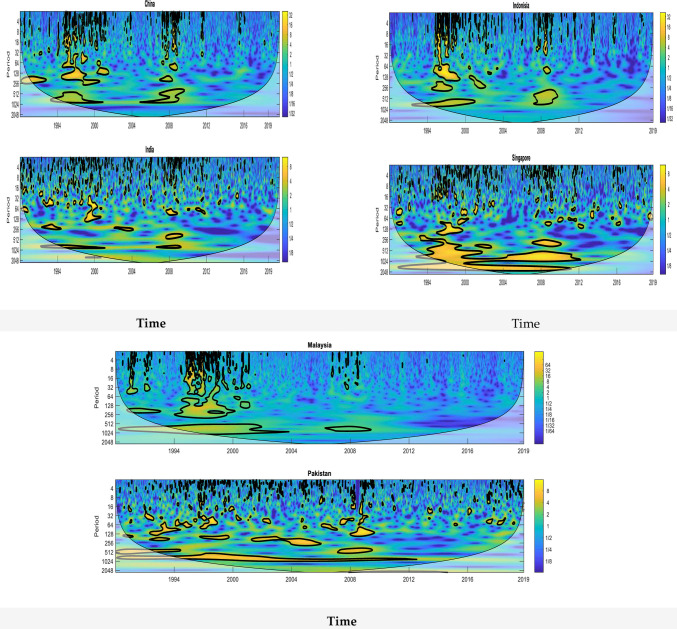
Wavelet power spectra of emerging stock market.The color code for power ranges from dark blue (low power) to dark red (high power). A black thick contour encloses regions of 5% cumulative area wise significance Time (year) and frequency (period) are represented on the horizontal and the vertical axis, respectively.